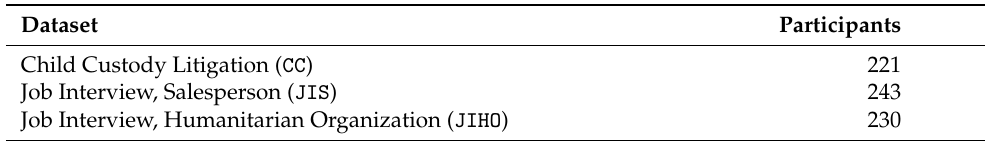
Table 1. Number of participants that took part in each of our data collection experiments. Each of the participants completed the questionnaire twice, the first time responding honestly and the second time altering his/her responses to achieve different